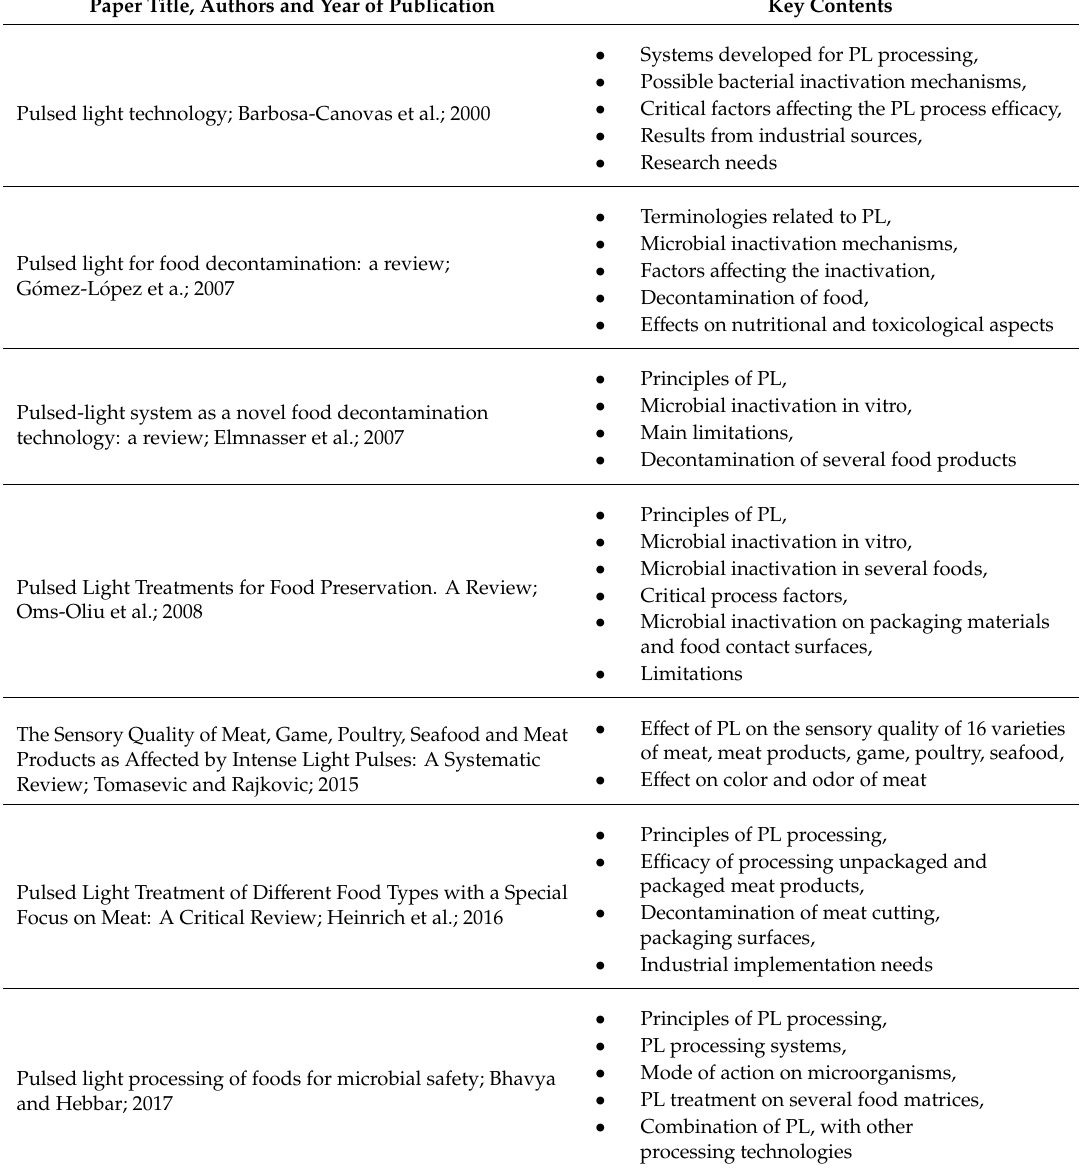
Table 1. Previously published review papers on PL